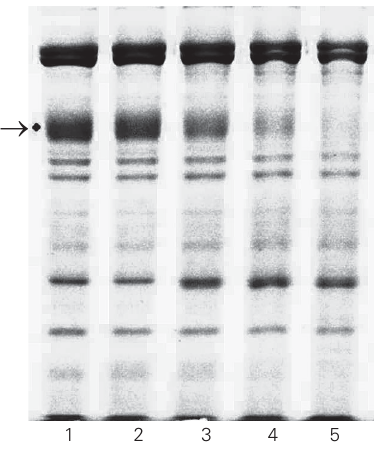
Figure 1. SDS-PAGE of red blood cell ghosts from patients with the viscerocutaneous form of loxoscelism incubated with spi- der venom. The conditions are given in the legend to Table 1. The arrow on the left points to the position of band 3. No inhibi- tors were employed during ghost preparation. Lane 1 , con- trol ghosts without incubation; lane 2 , control ghosts + venom with no incubation; lane 3 ,